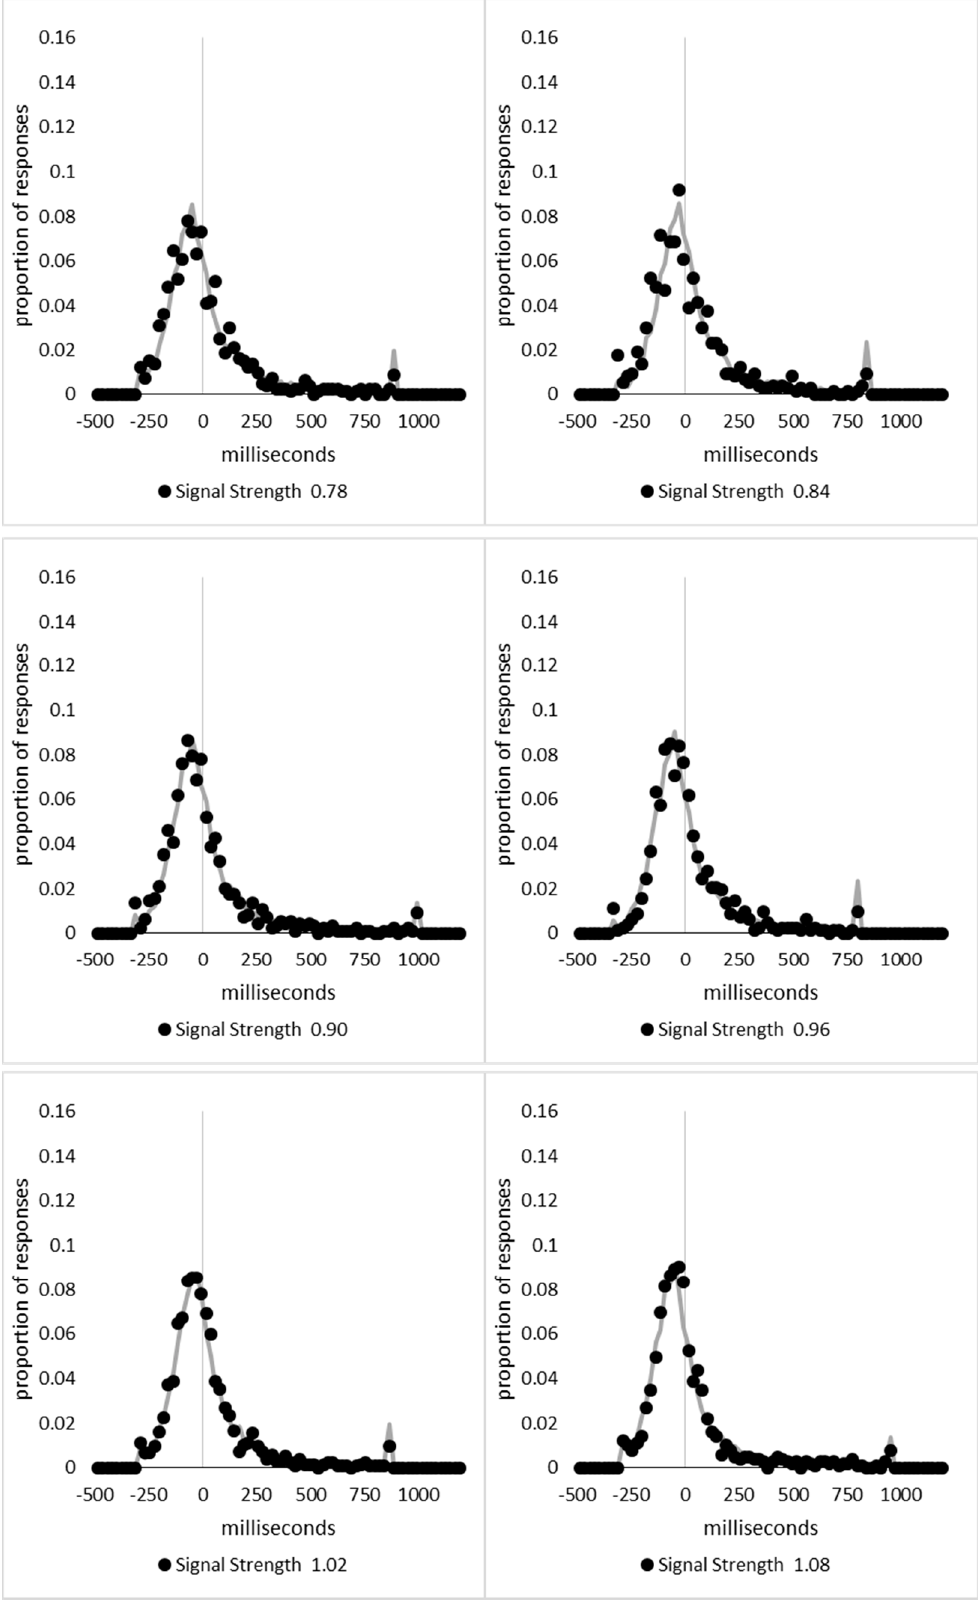
Figure A3. Density functions of the observed data (filled circles) and model (solid line) for signal strength bins 0.78 to 1.08.